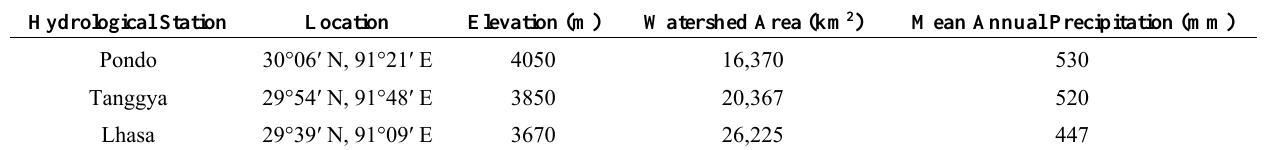
Figure 1. ( a ) Topographic map; ( b ) the river network of the Lhasa River basin. Table 2. Information of hydrological stations in the Lhasa River